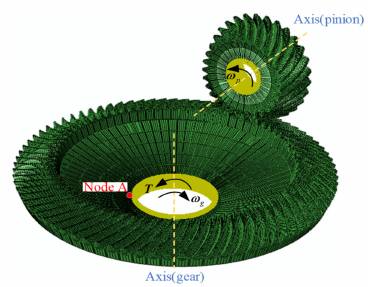
Figure 2. Mesh model and constraint